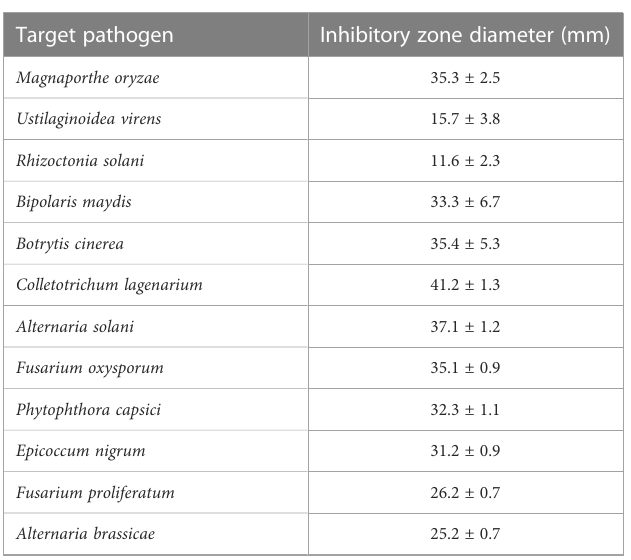
TABLE 2 Inhibition spectrum of JK-34 fermentation fi ltrate.